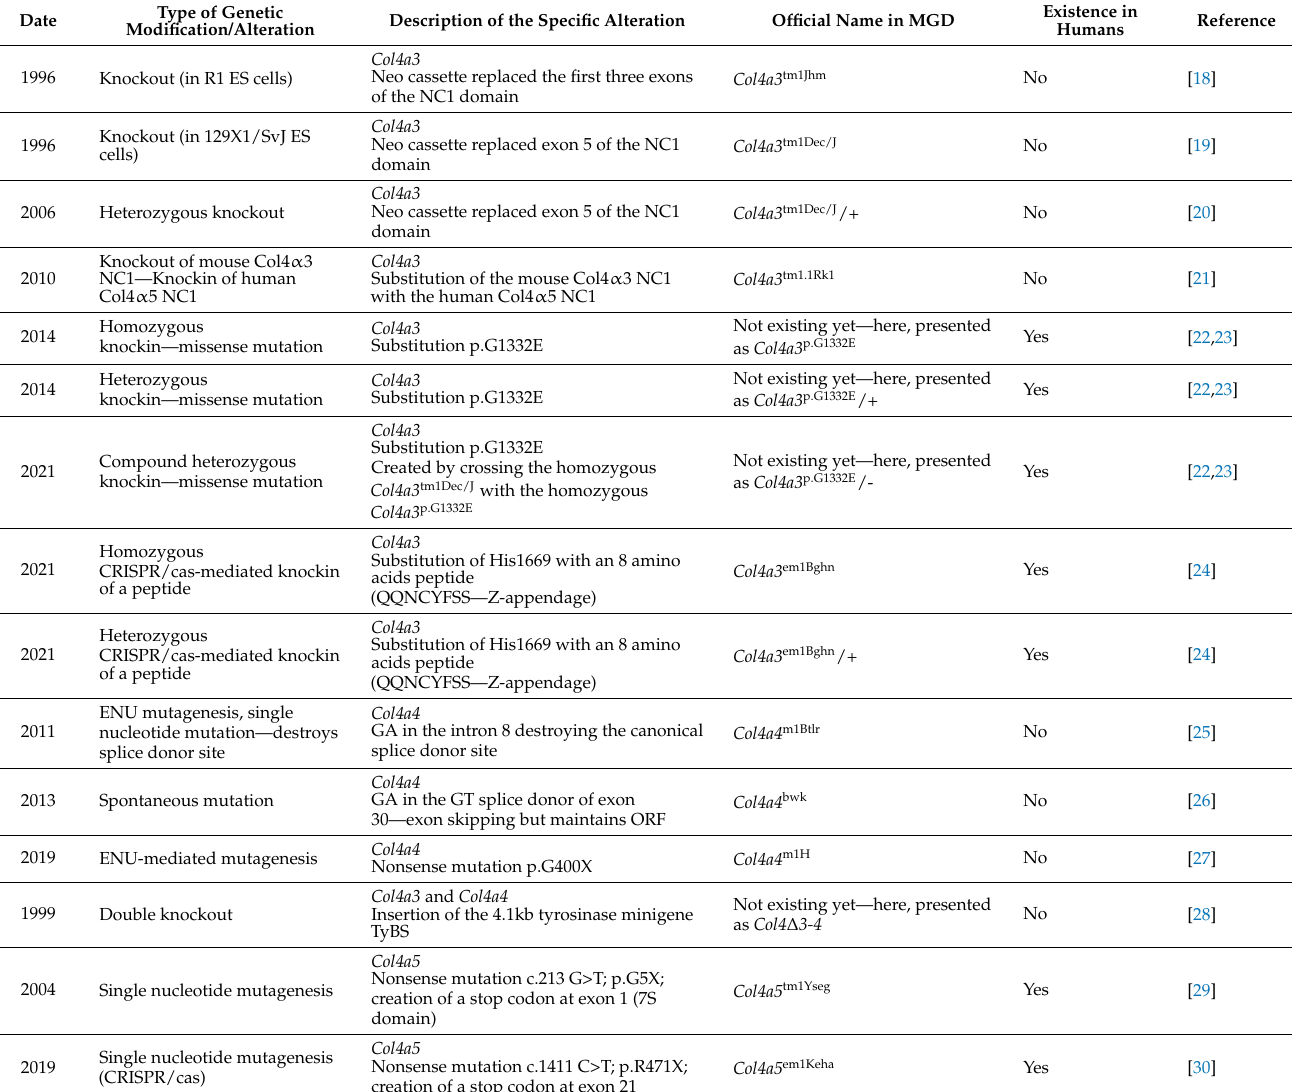
Table 1. Existing mouse models of Alport syndrome and their genetic alterations. MGD: